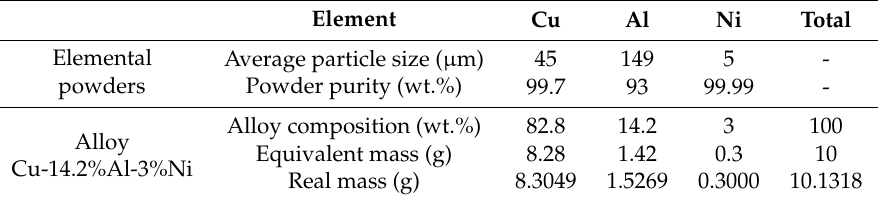
Table 1. Quality of the elemental powders used for alloy fabrication and an example of determining the quantities necessary for fabricating alloy of nominal composition Cu-14.2%Al-3%Ni.